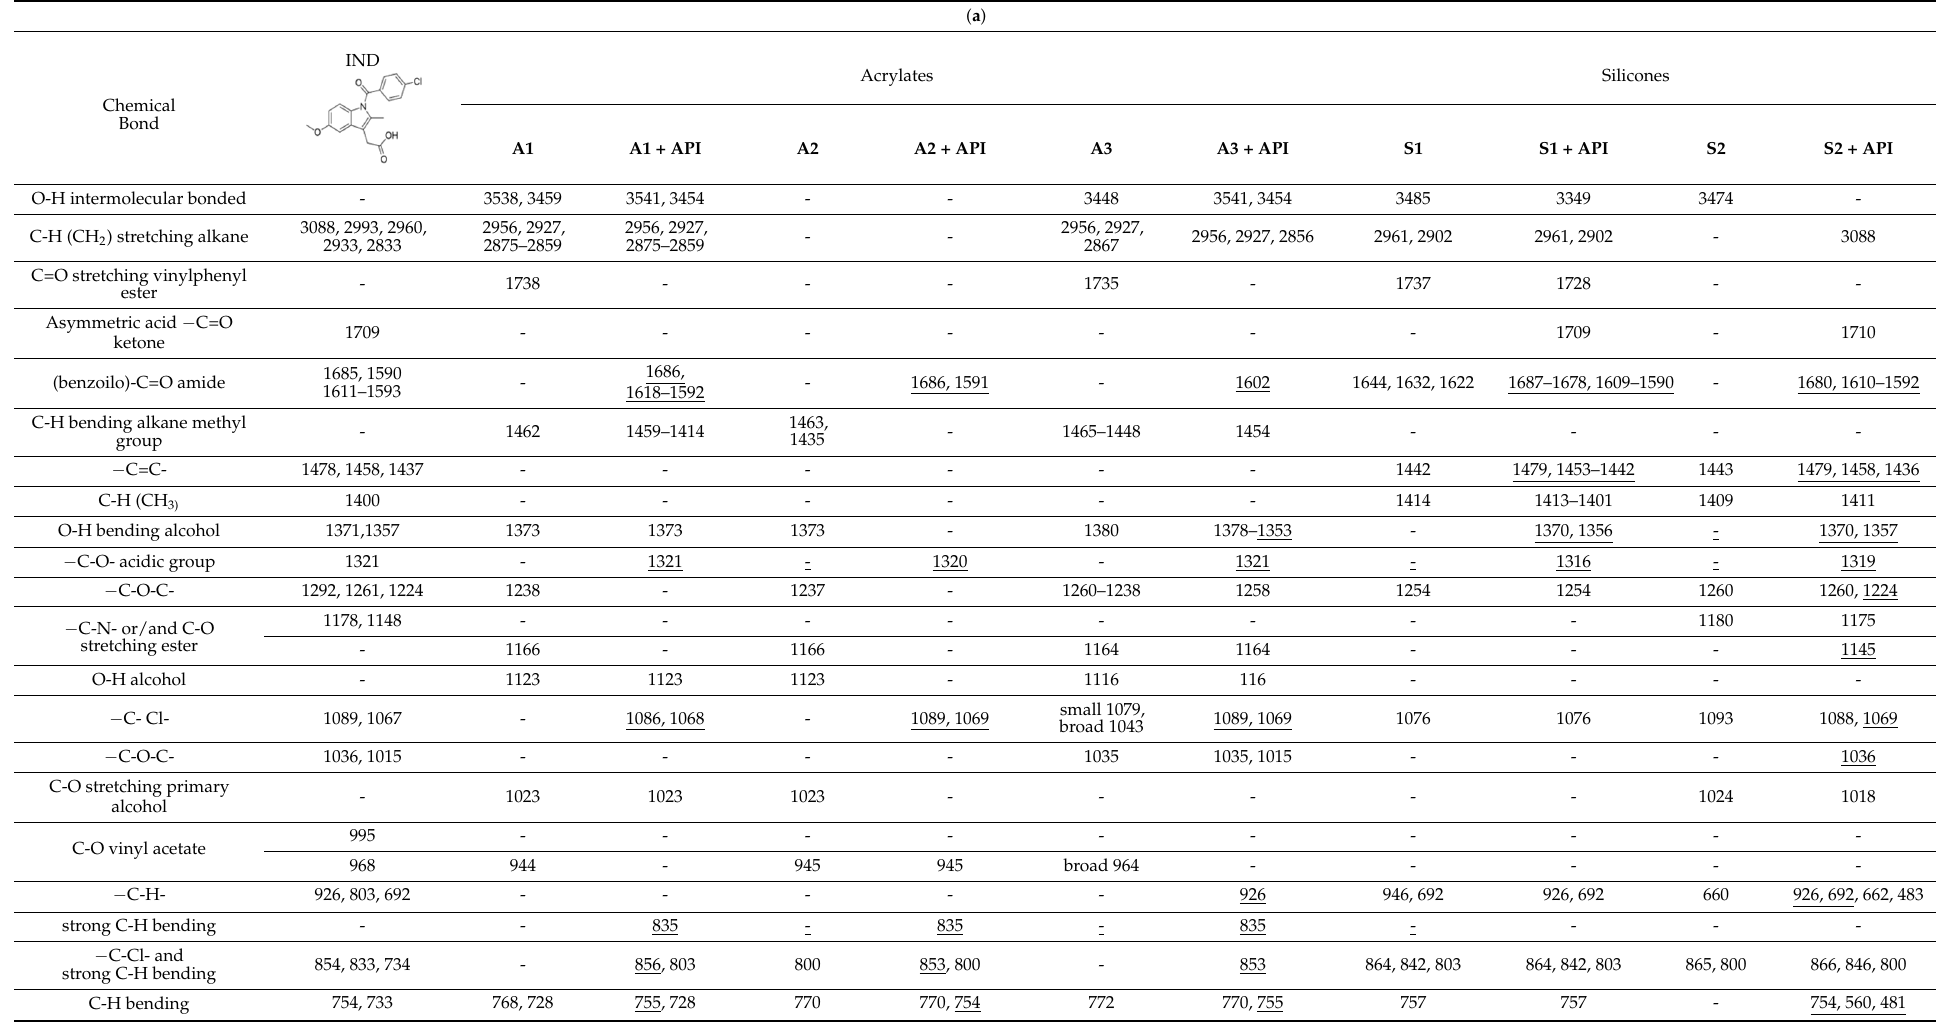
Figure 1. FTIR spectra of the investigated placebo patches: ( a ) polyacrylates; and ( b ) polysiloxanes. The grey bands mark differences or similarities between the polymers’ spectra. Table 3. FTIR identification of IND (a), CYT (b) and TST (c) in the polymeric matrices (bands or wavenumber ranges underlined are characteristic of API identification in respective patches and not present in placebo polymer film) [19–22].